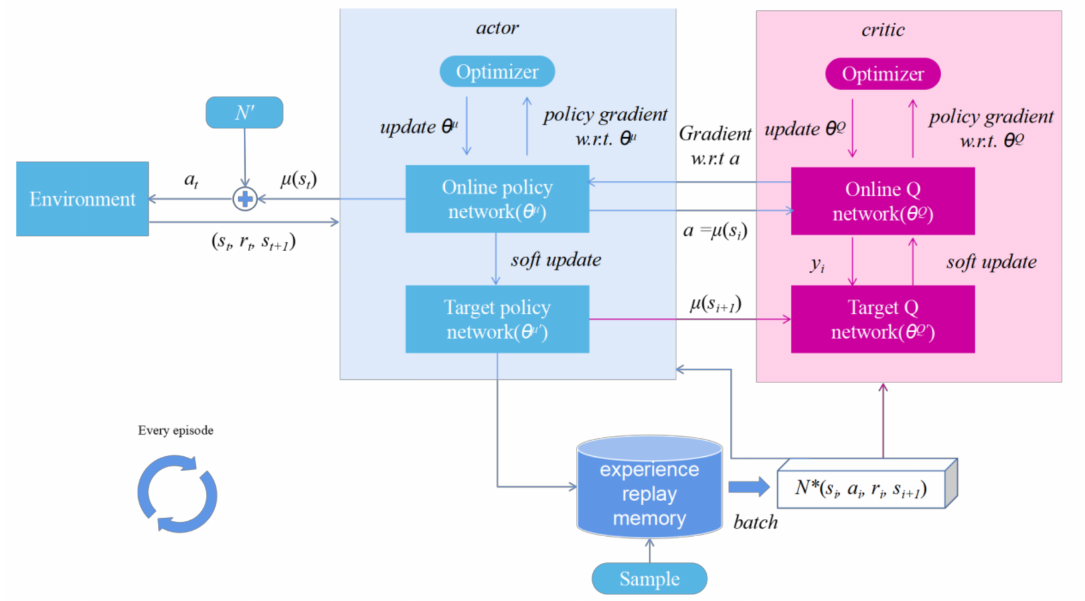
Figure 3. The principle of network parameters updating for DDPG